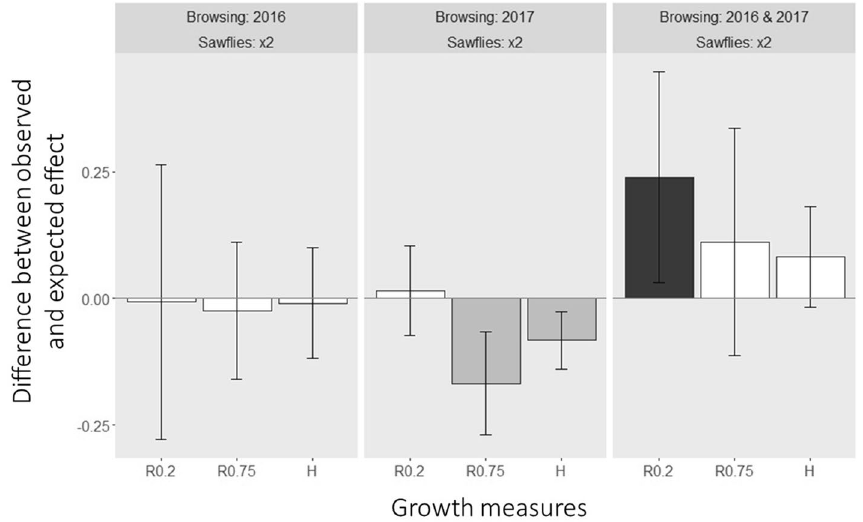
Figure 3. Difference between observed and expected effects of multiple herbivory on tree growth after two growing seasons for trees exposed to clipping and repeated sawfly herbivory (× 2). Expected values are based on the sum of the separate treatments (calculated according to Bansal et al. 2013). Dark grey bars represent synergistic effects, light grey bars antagonistic effects and white bars represent additive effects. Bars and error bars represent the effect size difference (mean and 95% confidence interval around the mean). If the mean and both ends of the confidence interval are above zero growth effects are considered synergistic and if the mean and both ends of the confidence interval is below zero, effects are considered antagonistic. The zero line represents the expected additive